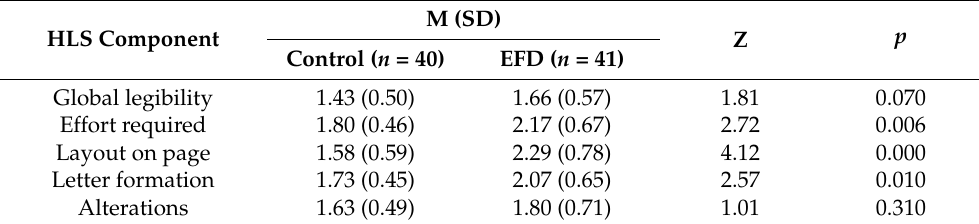
Table 1. Between-group differences in the HLS